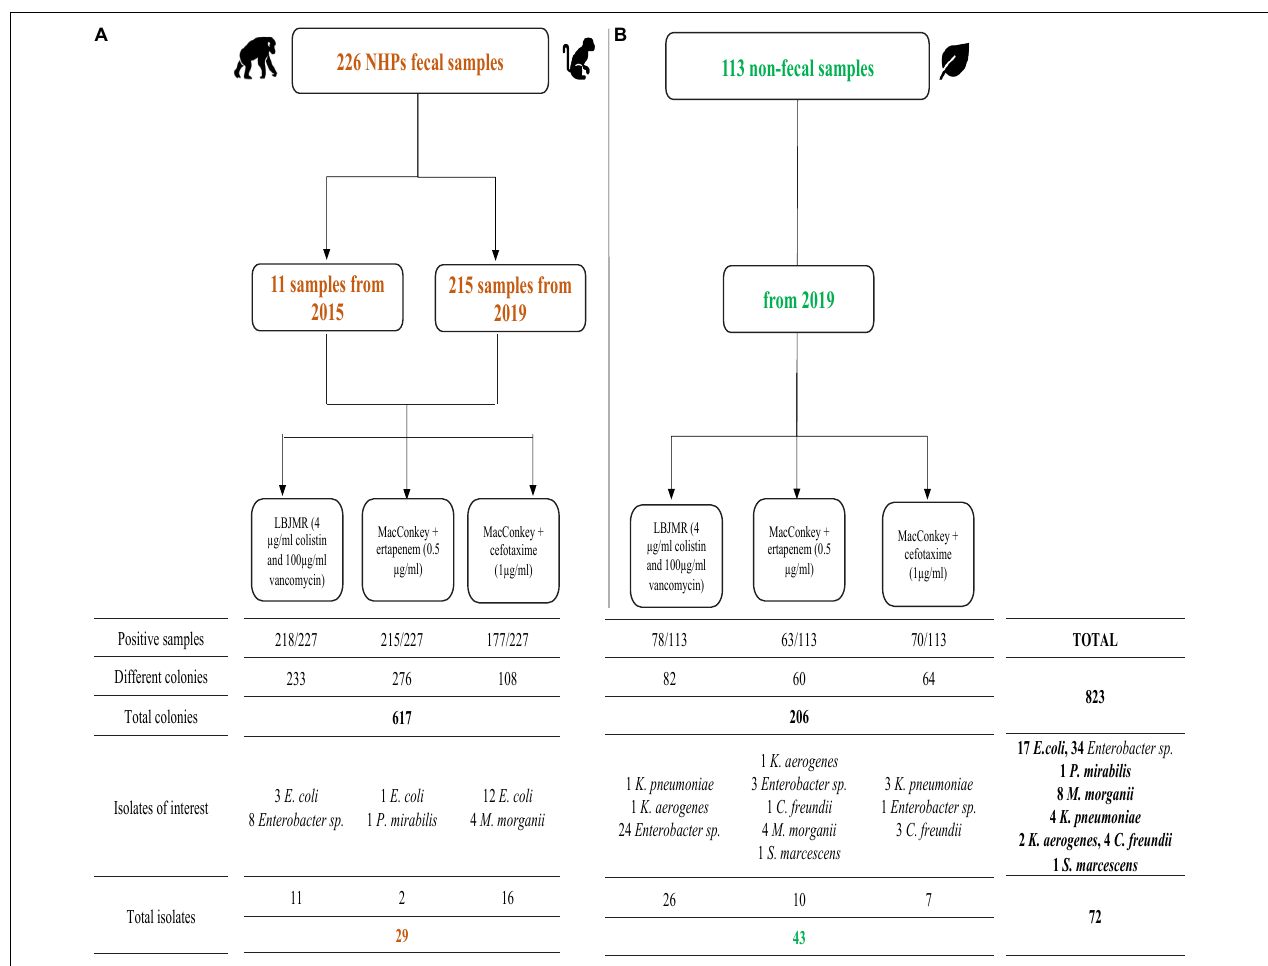
FIGURE 1 | Summary of positive non-human primates (NHPs) fecal samples (A) and non-fecal environmental samples (B) cultures on different selective media. Isolates of interest are those that were sequenced.